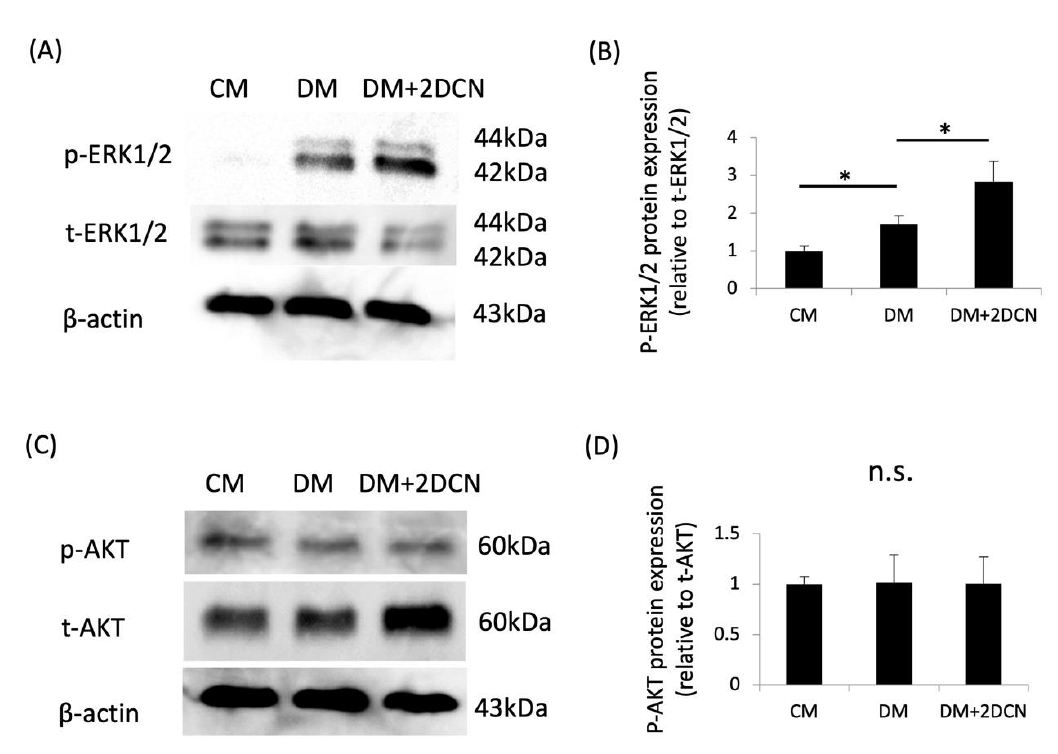
Figure 4. Expression of phosphorylated-ERK1/2 and phosphorylated-AKT during the DCN-induced osteoblastic differentiation of HPDLSCs. HPDLSCs were cultured in 10% FBS/ α -MEM (CM), CM with 1.5 mM CaCl 2 (DM), or DM on a 2 µ g/mL DCN coating (DM + 2 DCN) for 15 min. ( A ) Western blot analysis was performed to determine the expression of phosphorylated-ERK1/2 (p-ERK 1/2) and total-ERK1/2 (t-ERK 1/2). β -actin was used as a loading control. ( B ) The graph shows the quantification of p-ERK 1/2 expression. Normalization of protein expression was performed against t-ERK1/2 expression. ( C ) Western blot analysis was performed to determine the expression of phosphorylated-AKT (p-AKT) and total-AKT(t-AKT). β -actin was used as a loading control. ( D ) The graphs show the quantification of p-AKT expression. Normalization of protein expression was performed against t-AKT expression. Values are the mean ± SD of three indepenDent. experiments.